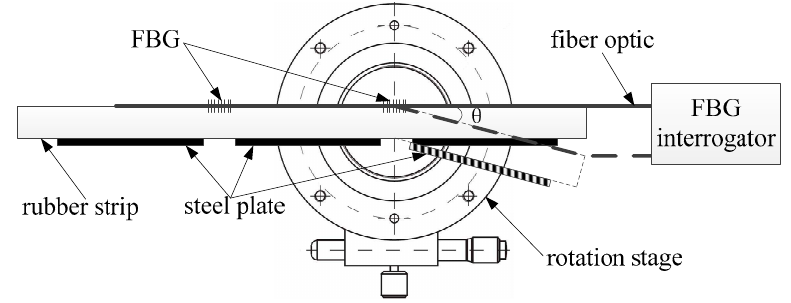
Figure 5. The test system of the FBG strain sensor.